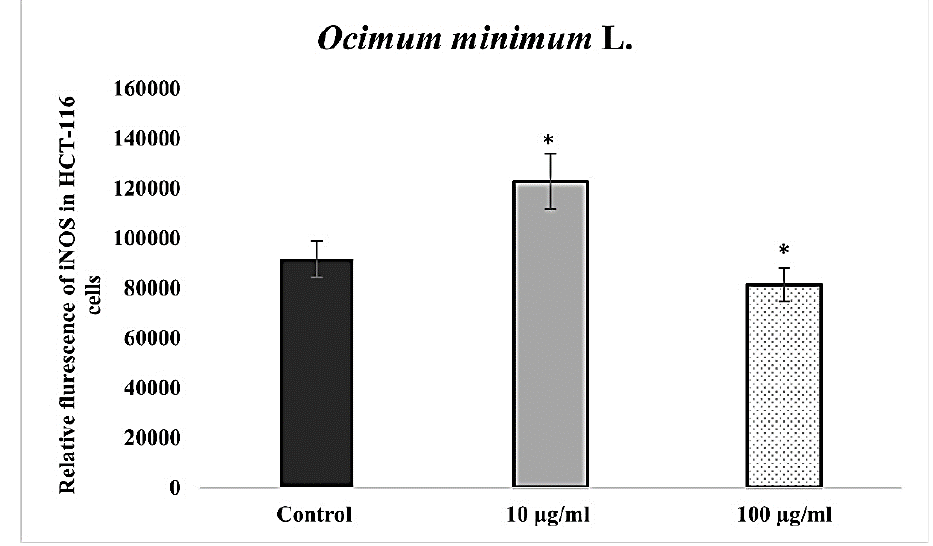
Figure 5. The protein level of iNOS in HCT-116 colorectal carcinoma control and cells treated with O. minimum (10 and 100 μg/mL), 24 h after treatments. The data are means ± SE of two independent experiments. *p<0.05 compared to untreated cells.